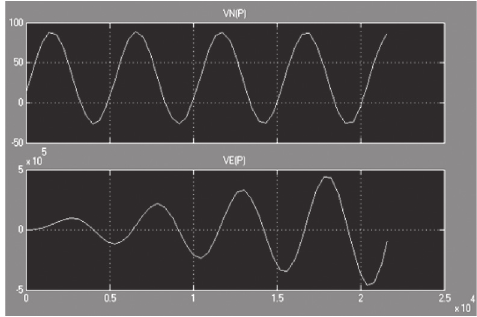
Fig. 9. The graphs of error rates of speed of two channels of an inertial system when between the channels there are three cross connections with factors of transmission knpv = 0.001, knpv1F = 0.001, and knpv2F = 0.001